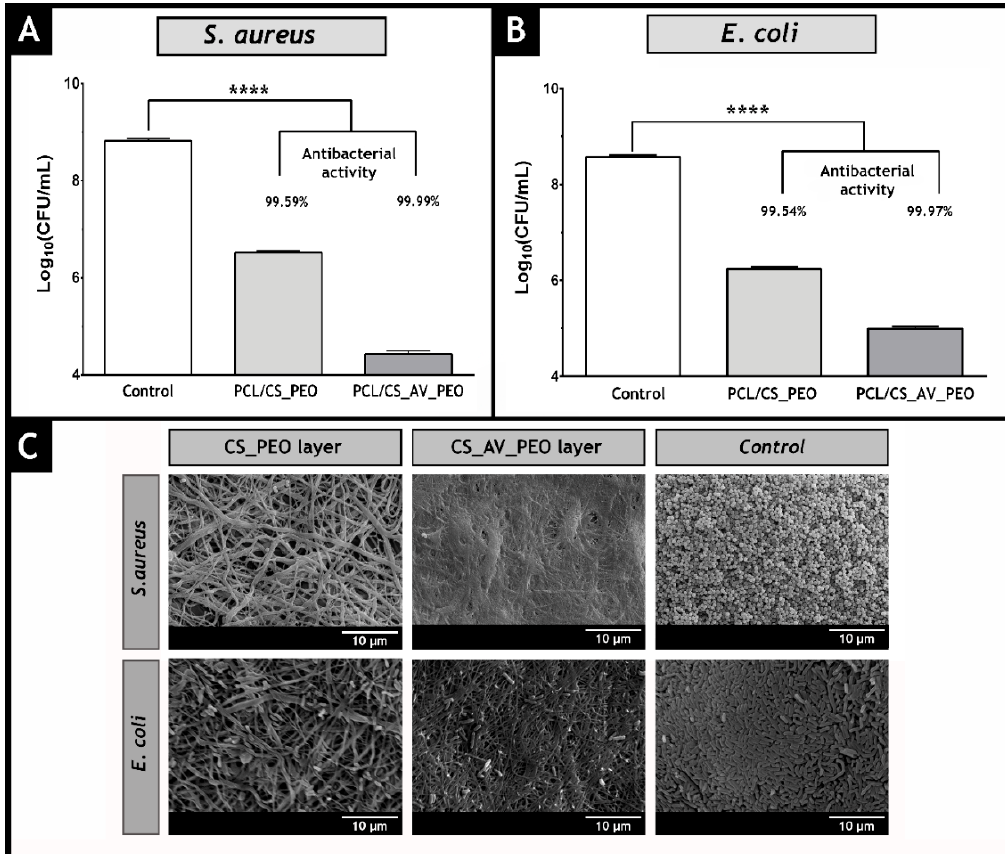
Figure 10. Evaluation of the bactericidal activity of the produced membranes. The antibacterial activity of PCL/CS_PEO and PCL/CS_AV_PEO membranes against S. aureus and E. coli is presented in ( A , B ), respectively; SEM images of S. aureus and E. coli in contact with PCL/CS_PEO and PCL/CS_AV_PEO membranes and of the negative controls are displayed in ( C ).